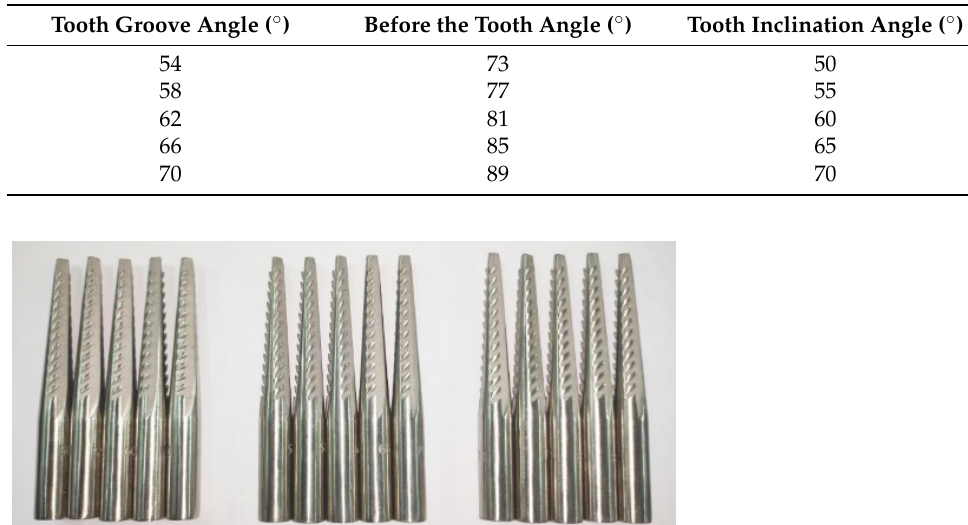
Table 1. The tooth angle factors of the spindle hook.